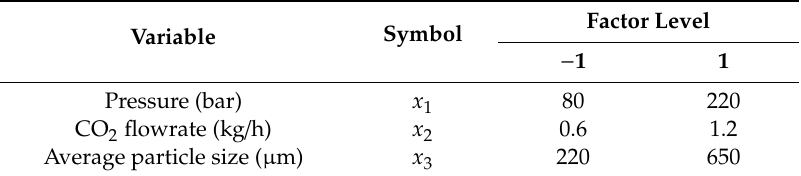
Table 2. Conditions of supercritical fluid